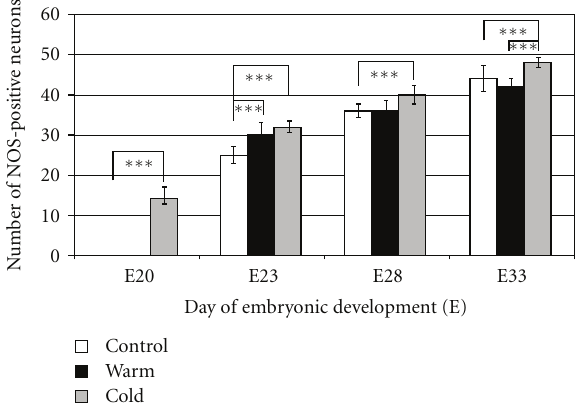
Figure 2: Hypothalamic nNOS expression in 20- to 33-days-old Muscovy duck embryos under di ff erent temperature treatments (control: constant 37.5 ◦ C, warm: 3 h 39 ◦ C, cold: 3 h 34 ◦ C before start of the experiments). Each column represents mean values ± SD of 100 (100 × 100 μ m) rectangle fields from 4–8 brain slices of each experimental group. Investigations were carried out in 80 embryos (see Table 1). Asterisks represent significance at the level of P < 0 .